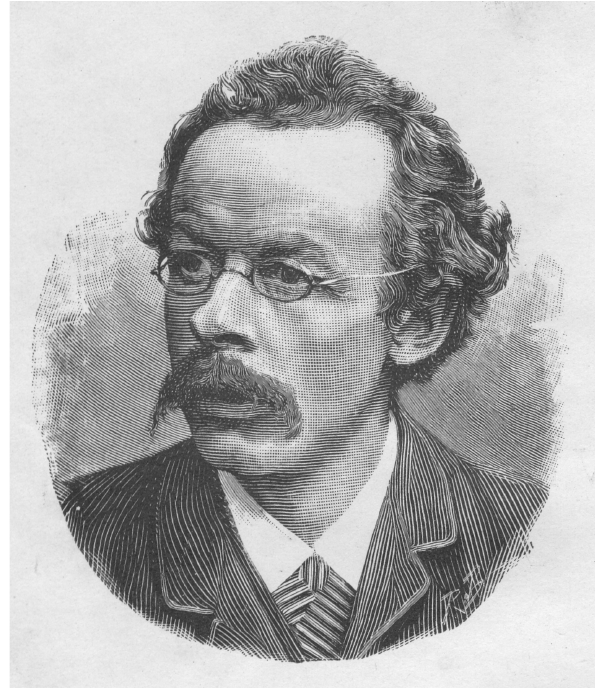
Figure 2. Sketches of auroras seen 25 January 1873, from Svan- holmsminde (from Tromholt,